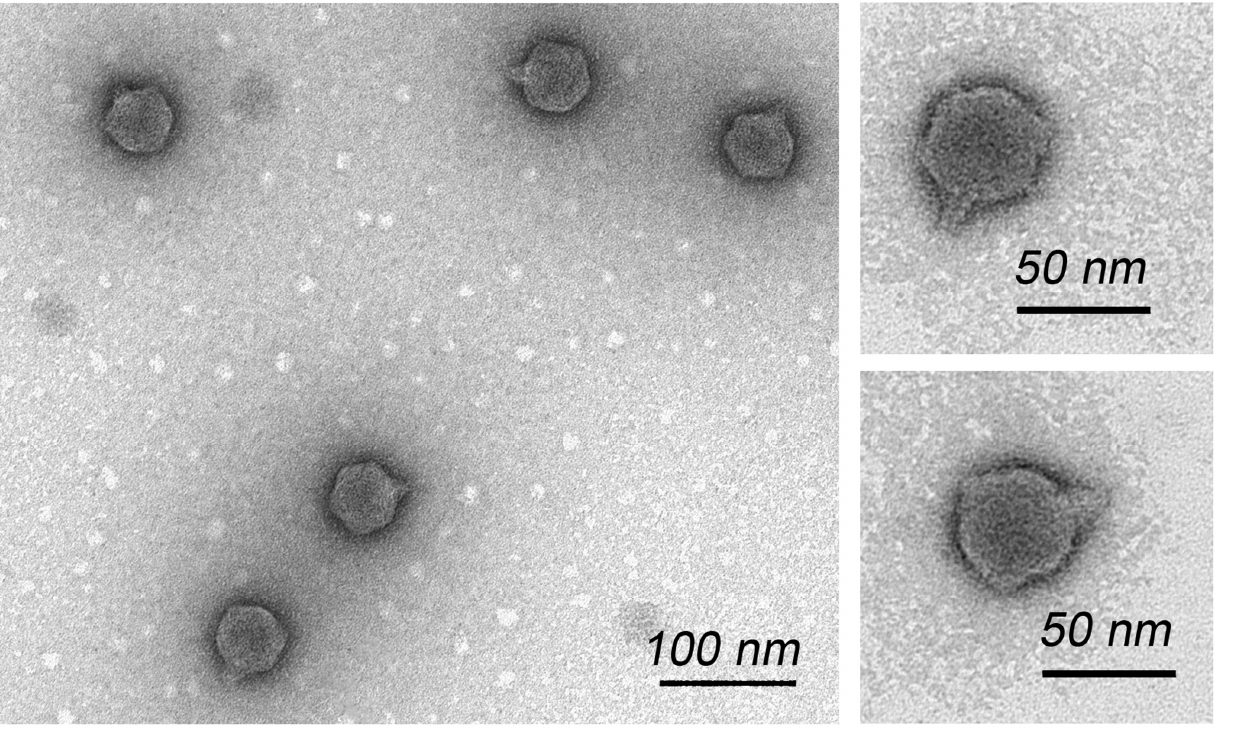
Figure 2. Transmission electron microscopy of Pseudomonas phage Pf-10 negatively stained with 1% (w/v) uranyl acetate. Scale bar: 100 nm and 50 nm.